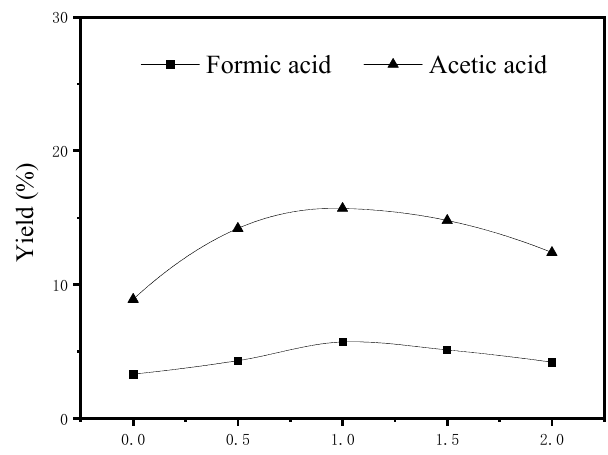
Figure 2. Effects of NaOH